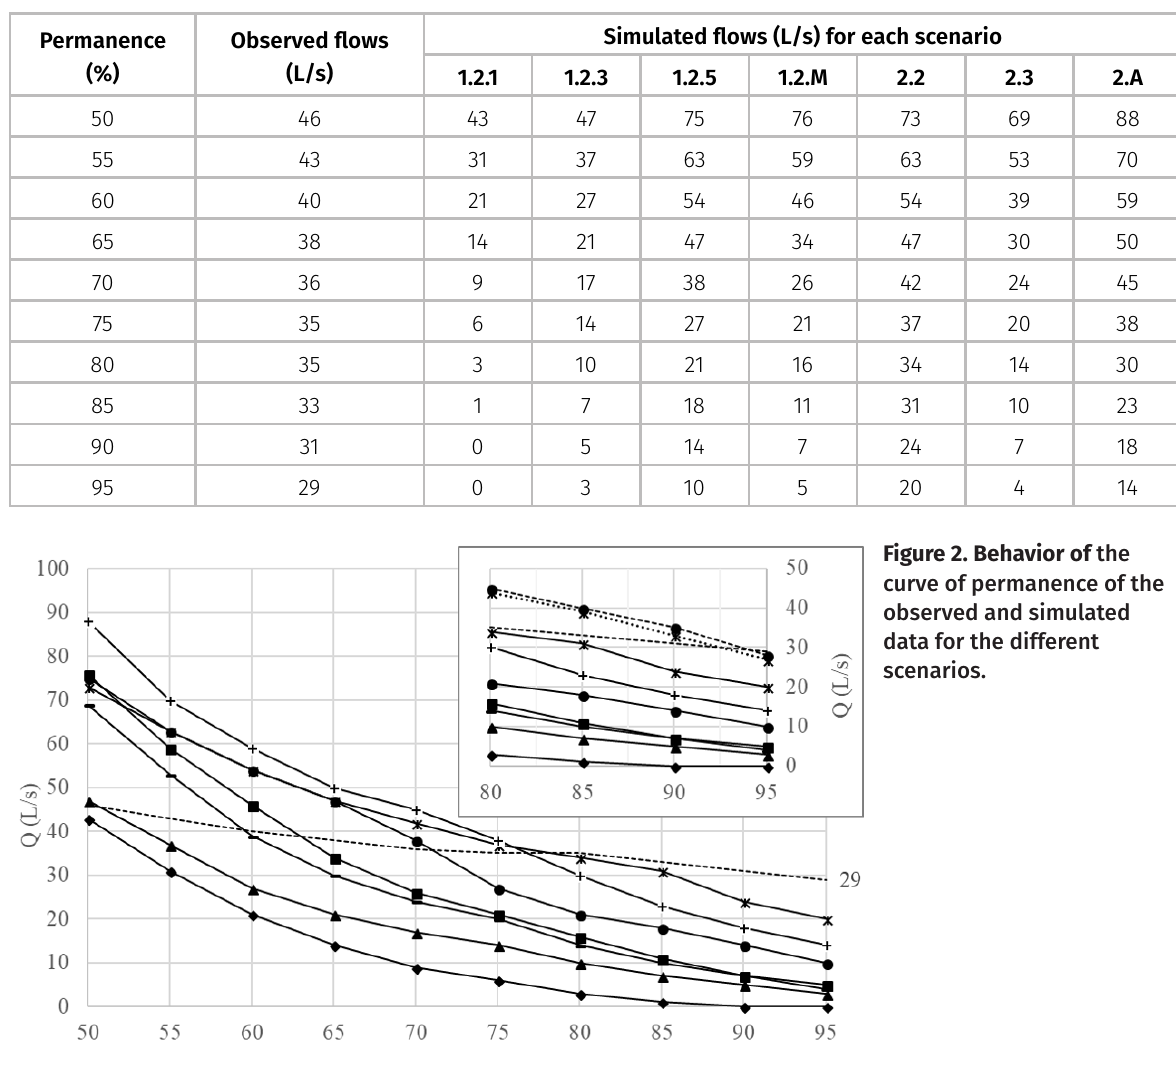
Figure 2. Behavior of the curve of permanence of the observed and simulated data for the different